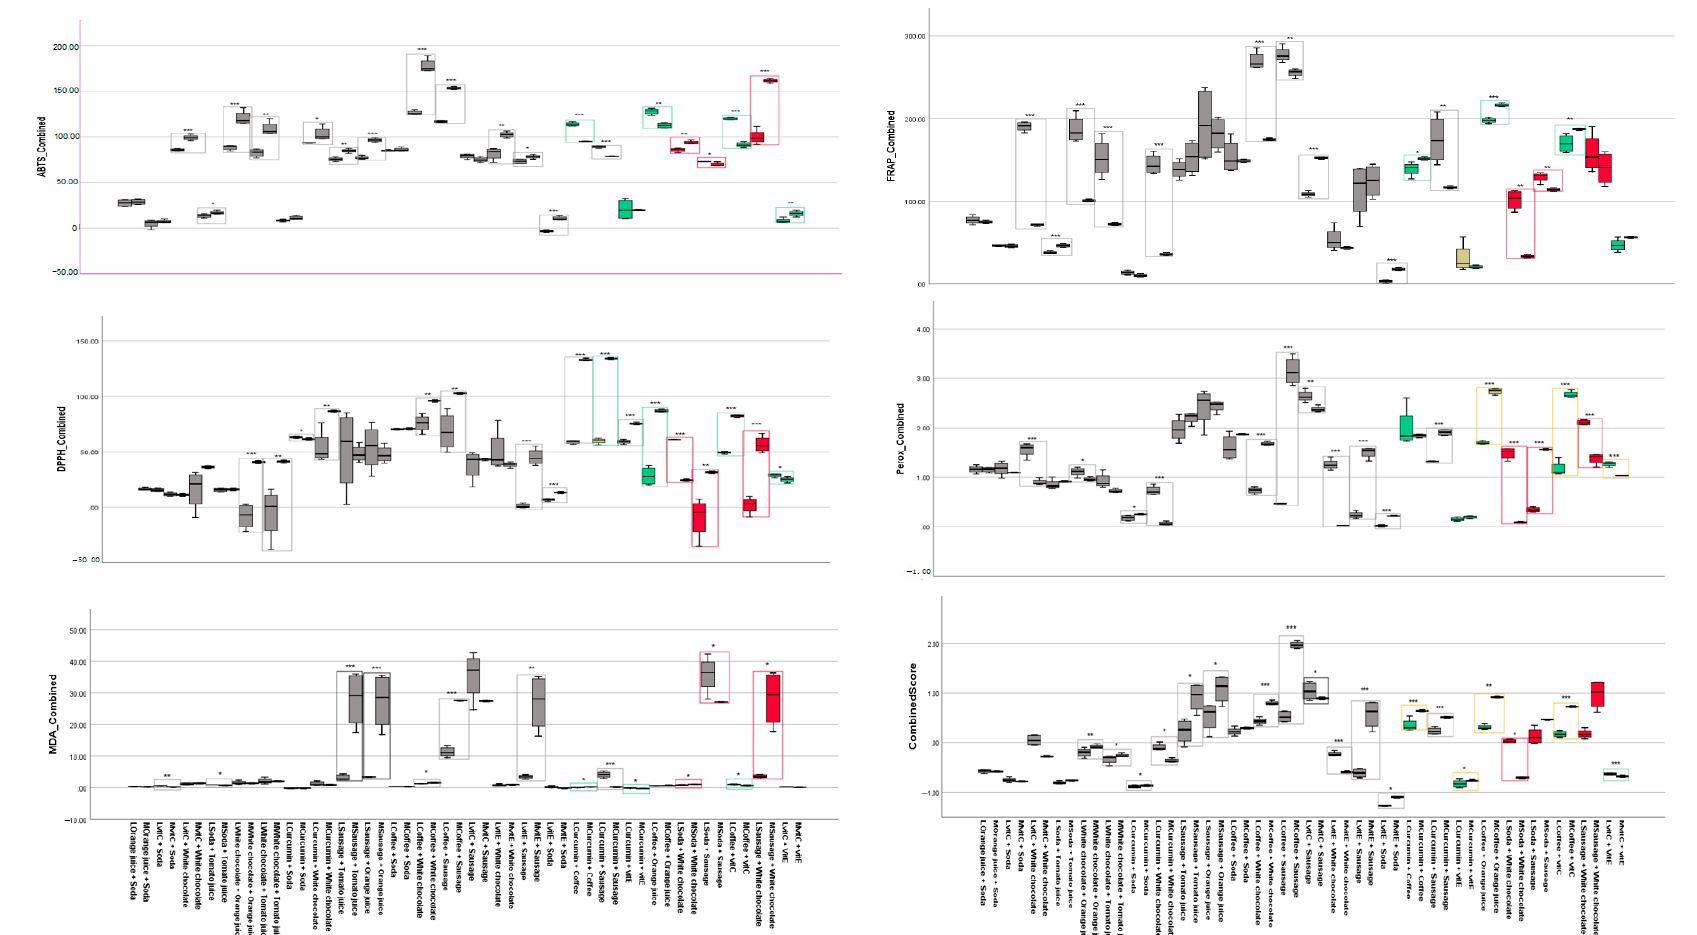
Figure 4. Pairwise (laboratory combinations vs. mathematical combinations) comparisons using t -tests. Note that all values were baseline (control digestion) subtracted. p -values: * < 0.01, ** < 0.001, *** < 0.0001. L = laboratory combinations, i.e., digested together, M = mathematical combinations. Pink color indicates the respective blank. Green colors represent presumably antioxidant-rich food combinations, red ones presumably pro-oxidant food combinations, grey colors indicate a combination of one pro-and one antioxidant food item.